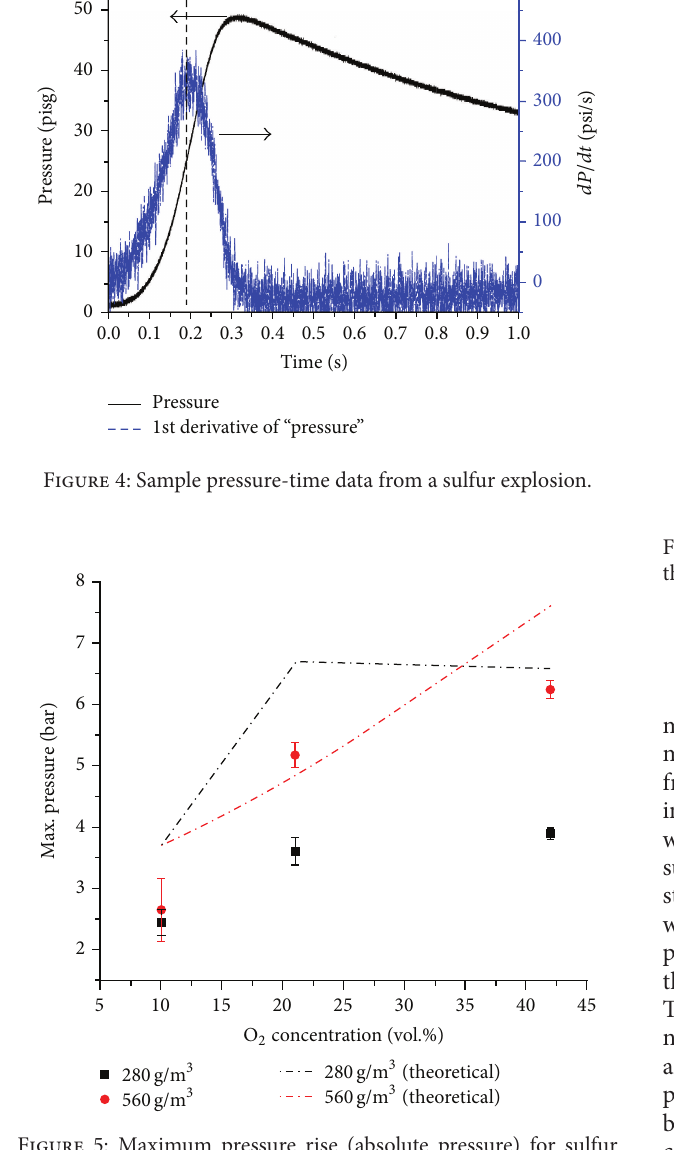
Figure 5: Maximum pressure rise (absolute pressure) for sulfur explosions within a 31 L chamber.